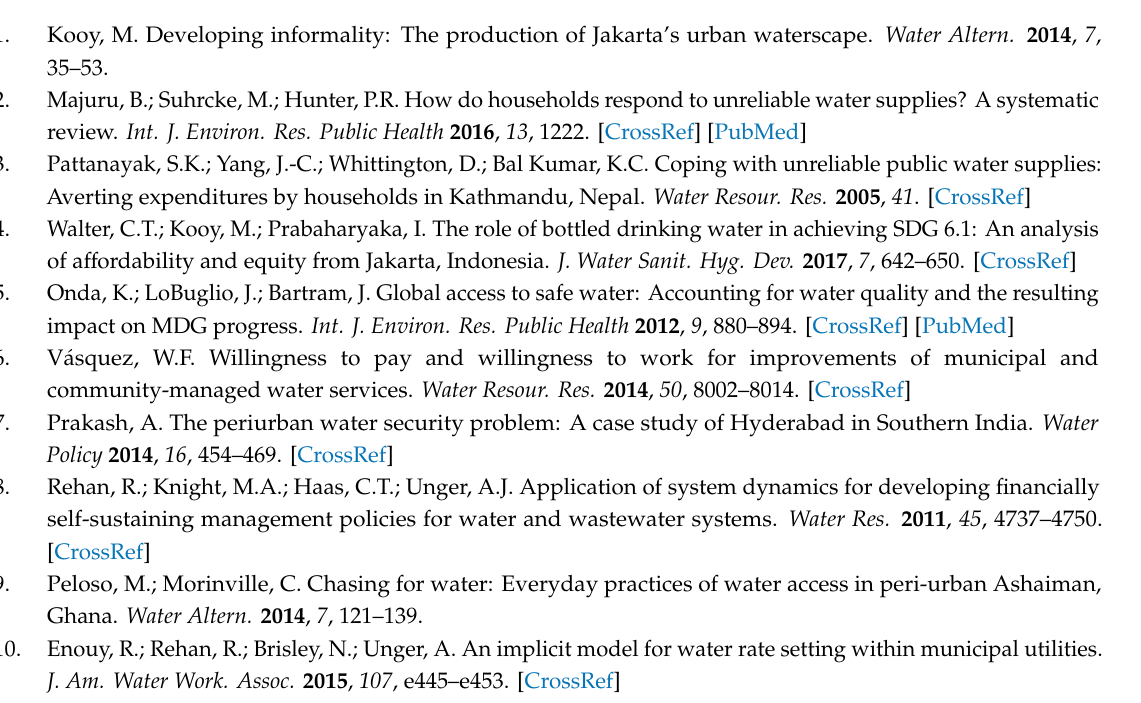
Figure S1: System components of the socio-hydrological processes captured in the study, Figure S2: Formal water balance sector, Figure S3: Infrastructure condition sector, Figure S4: Consumer sector, Figure S5: Financial balance sector. Figure S6: Infrastructure ageing, Figure S7: Informal demand versus formal supply balance per household, Figure S8: The Area under the ROC Curve - Logistic Regression analysis, Text S1: Informal demand and WTP to formal (Logistic Regression Analysis), Table S1: Logistic Regression Coe ffi cients and Table S2: Calibrated